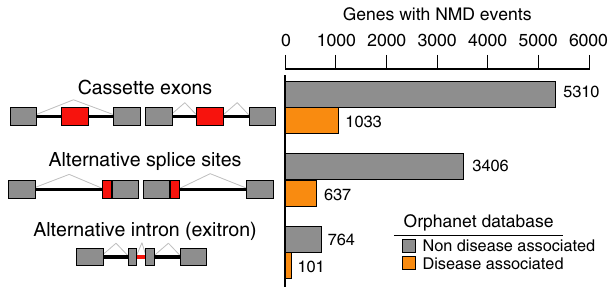
Fig. 1 Identi fi cation of protein-coding genes with NMD-inducing events. 7757 unique genes containing at least one non-productive AS events, of which 1246 unique genes are disease-associated. The left panel depicts the types of AS events (cassette exons, alternative splice sites, and alternative intron/exitron) that are predicted to undergo NMD. Exons are denoted by rectangles and introns by lines. Red rectangles or red lines denote non- productive AS region. Gray rectangles denote protein-coding exons. The right panel horizontal bar graph summarizes the number of protein-coding genes containing each of the non-productive AS event type. Gray bars depict non-disease-associated genes and orange bars depict disease- associated genes (source: Orphanet disease database). Note: genes can have multiple NMD events of different types (Supplementary Data 2), therefore some genes are included in more than one type of event. To calculate the total number of unique genes (7757 and 1246 unique disease- associated genes) with non-productive events, each gene was counted only once. Source data are provided as a Source Data fi (control), cells were harvested and RNA was extracted. Using this